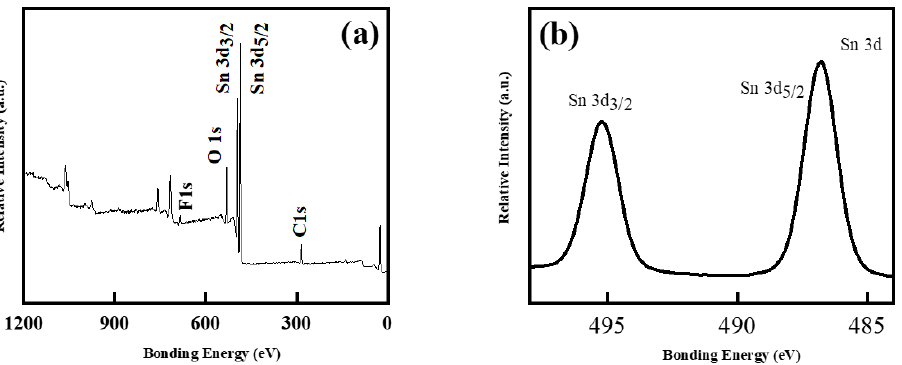
Figure 3. XPS spectrum of SnO 2 nanosheets: ( a ) survey XPS pattern; ( b ) high-resolution XPS of Sn 3d. FE-SEM and TEM images with different magnifications could provide information about the surface morphology and crystallographic properties of the as-received